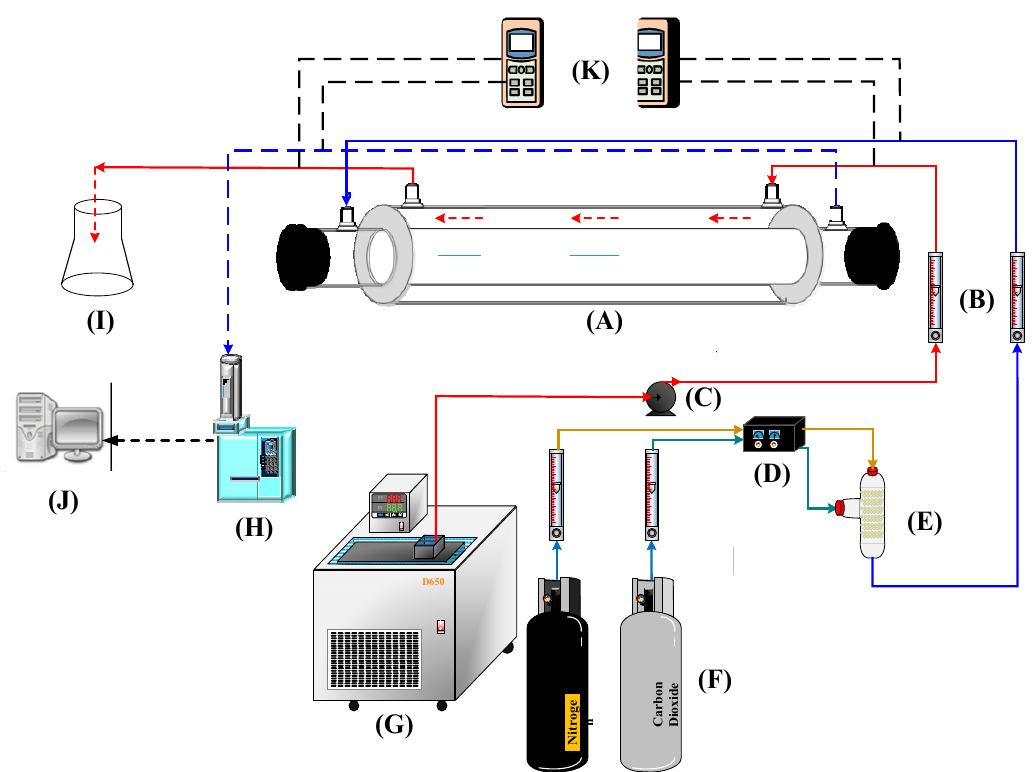
Figure 2. Experimental apparatus of the concentric circular gas/liquid membrane contactor system. ( A ) Concentric circular membrane contactor; ( B ) Flow meter; ( C ) Pump; ( D ) Mass flow controller; ( E ) Mixer; ( F ) Gas cylinder; ( G ) Thermostatic tank; ( H ) Chromatograph; ( I ) Beaker; ( J ) Monitor; ( K ) Temperature indicator.